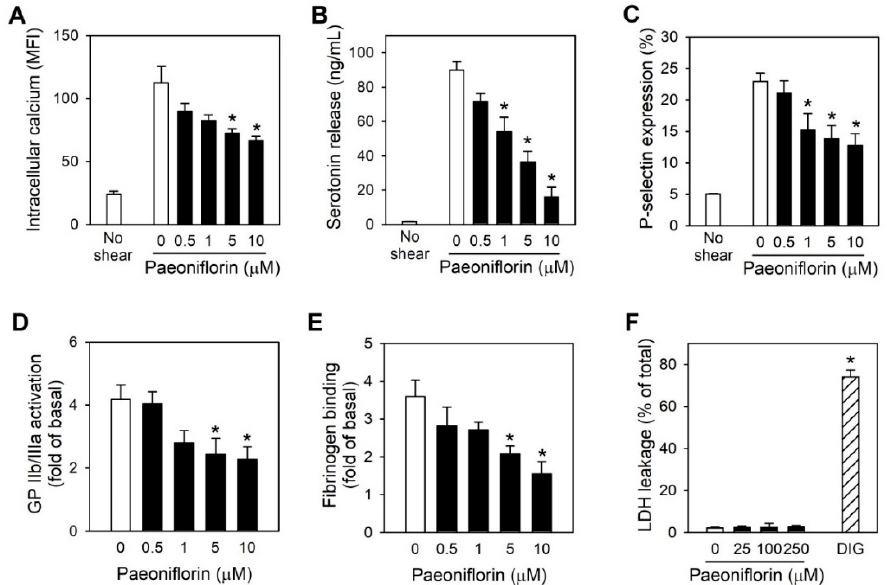
Figure 3. Effects of paeoniflorin on platelet activation events-triggered by shear stress. Human washed platelets were treated with different concentrations of paeoniflorin for 10 min before exposing to high shear stress. The intraplatelet signaling was investigated, including cytoplasmic calcium level was measured by using Fluo-4AM-loaded platelets ( A ) ( n = 4), serotonin release ( n = 4) was measured by ELISA ( B ), P-selectin expression ( C ) ( n = 4), GP IIb/IIIa activation ( D ) ( n = 4), and fibrinogen binding ( n = 4) ( E ) were measured by flow cytometry. ( F ) Cytotoxicity induced by paeoniflorin on platelets was measured by LDH leakage. (DIG, Digitonin 50 µM treatment for 1 h was used as positive control) ( n = 3). Values are mean ± SEM (expressed as the error bar) of the independent experiments from different blood donors. *, significant differences from control group ( p < 0.05).